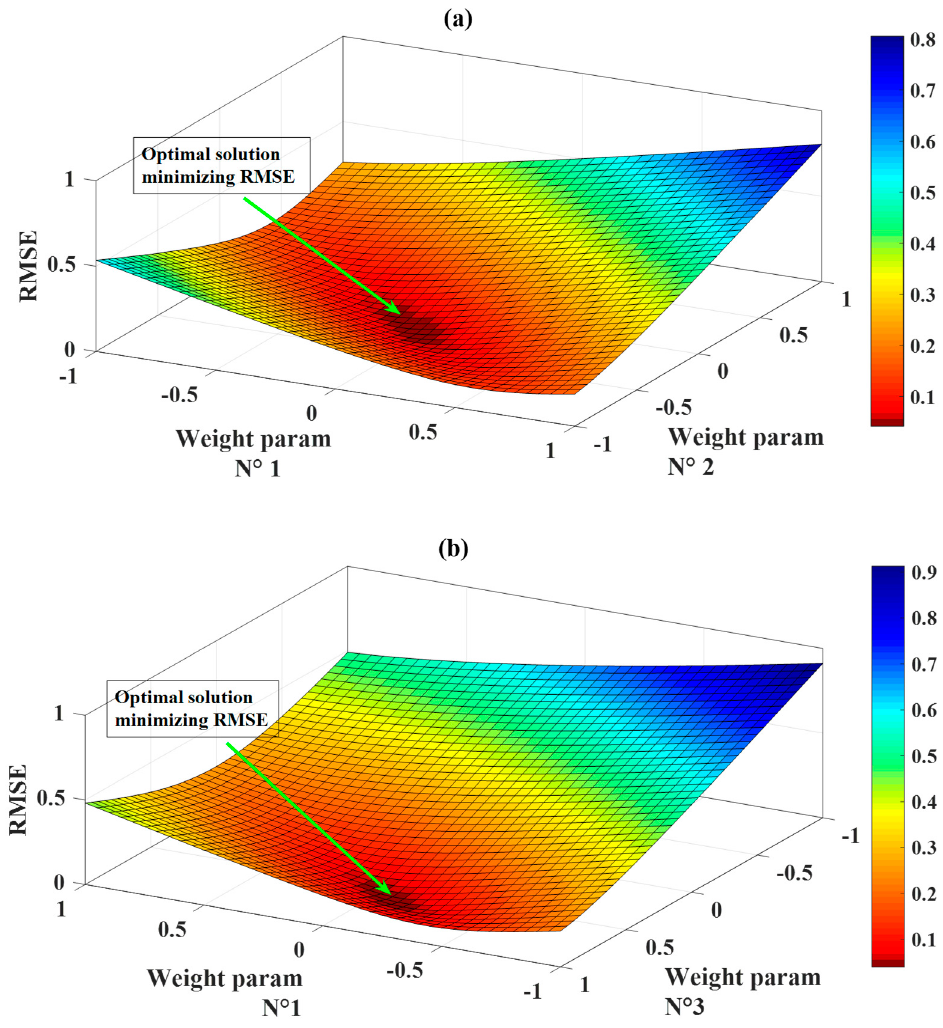
Figure 5. Verification of global optimum provided by the invasive weed optimization (IWO). The surfaces of root mean square error (RMSE) show unique optimal solution, which minimizes the value of RMSE: ( a ) between weight parameters N°1 and N°2, ( b ) between weight parameters N°1 and N°3.